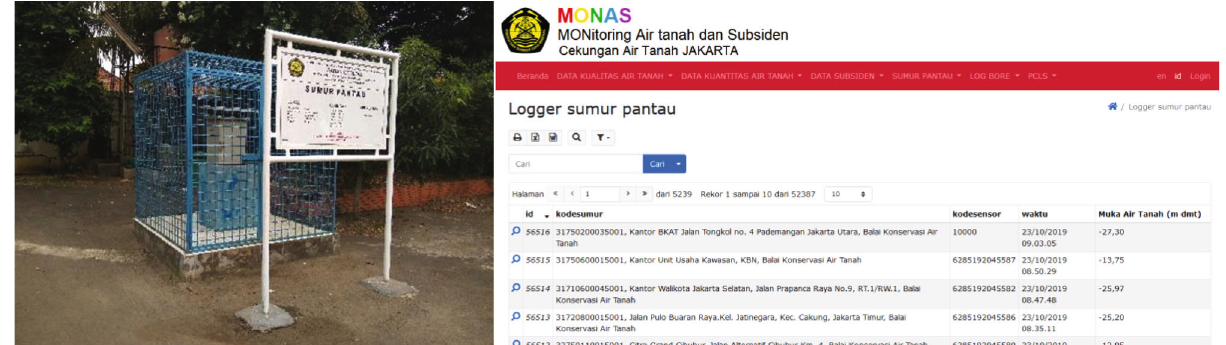
Figure 3: MONAS from BKAT.